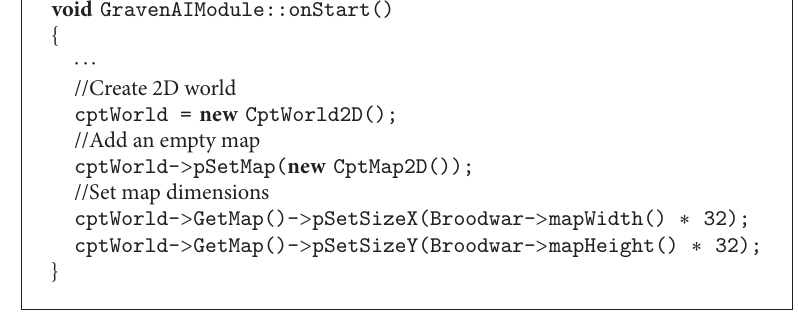
Algorithm 17: Conceptual view code in the onStart callback function. Map dimensions in BW are given in build tiles, each build tile representing a 32 by 32 area.